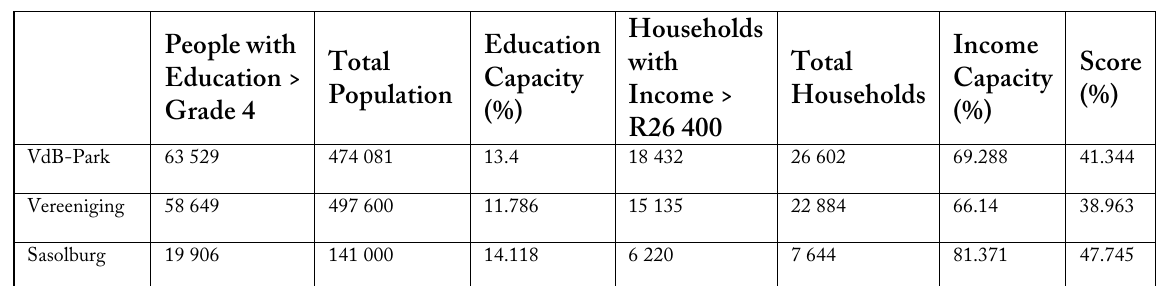
Table 4 Capacity component